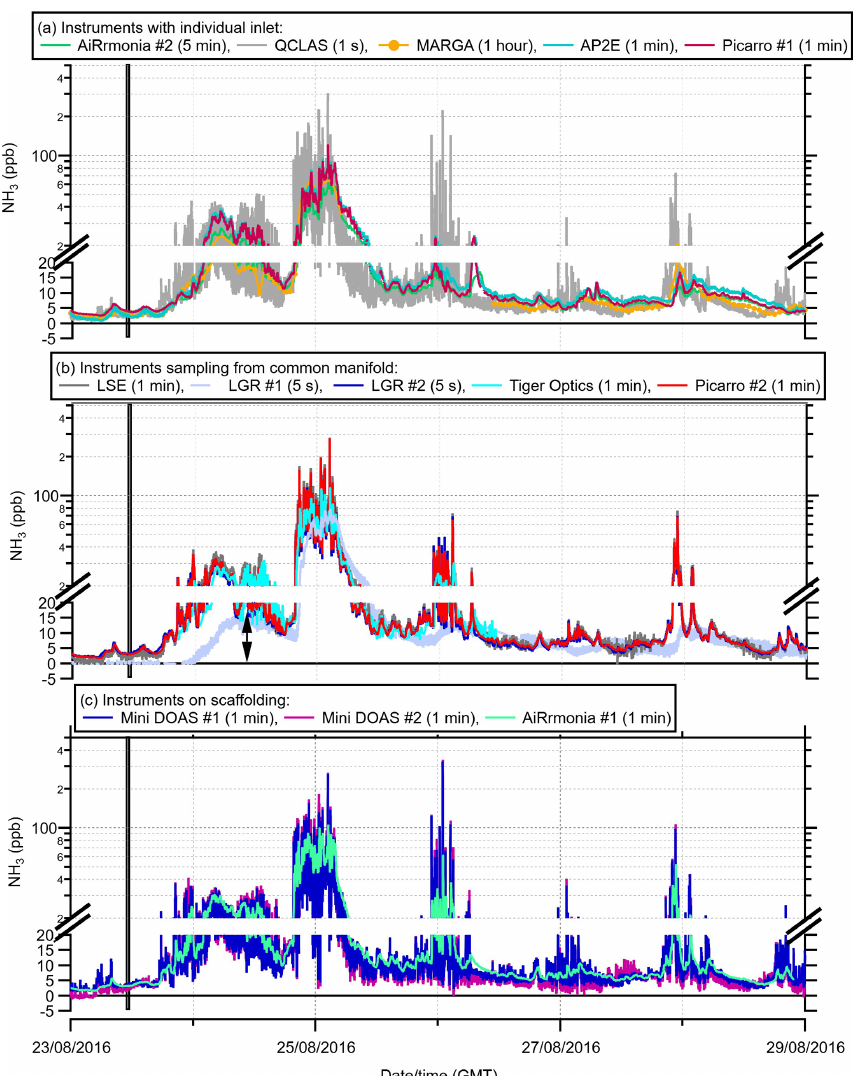
Figure 3. Summary of the reported concentrations from the instruments divided into categories: (a) instruments with individual inlet setup, (b) instruments subsampling from the manifold, and (c) instruments on scaffolding. The number in brackets is the reporting time resolution of each instrument. The thick black line is the fertilisation of both fields, the grey dashed line indicates the change in wind direction at 04:00 on the 25 August, and the black arrow indicates the point at which the laser position was changed on the LGR #1. Note: the scale changes at 20ppb to a log scale (supplementary figures plotting the data on linear scale can be found in Fig.